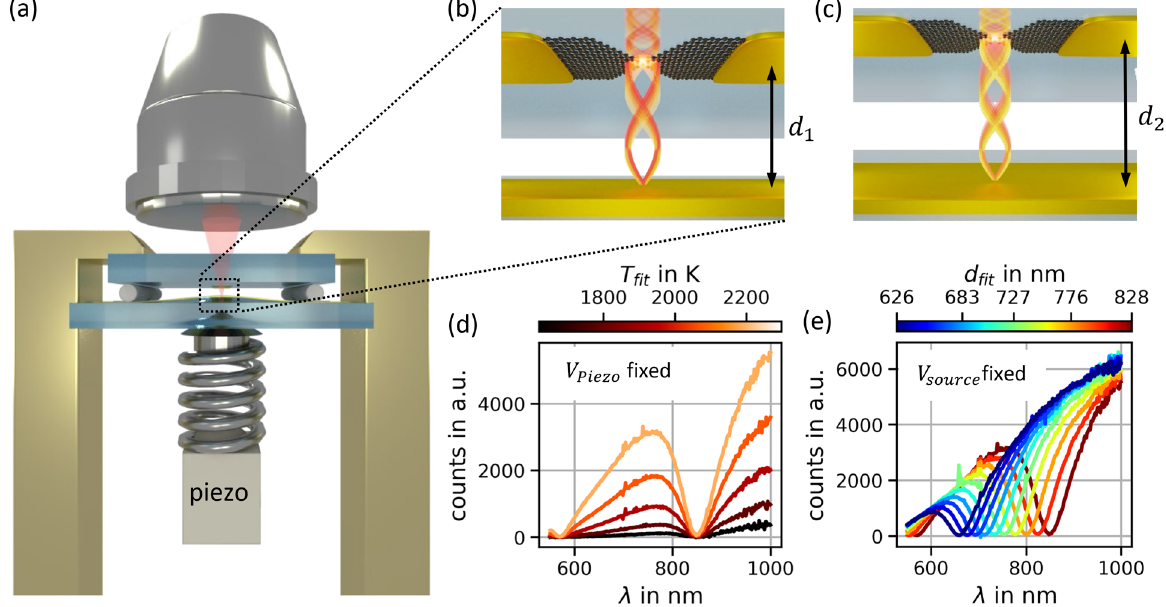
Figure 1. ( a ) Sqeezable nanojunction setup. ( b ) Graphene nanojunction placed in front of a gold mirror with standing wave modes of different wavelength. ( c ) Same as ( b ) but at increased distance. The electromagnetic node at the GNJ is associated with a higher wavelength. ( d ) Example spectra for varied driving voltage V source (resulting in varied temperatures). ( e ) Example spectra for varied distances (in between the physical situations depicted in ( b ) and ( c